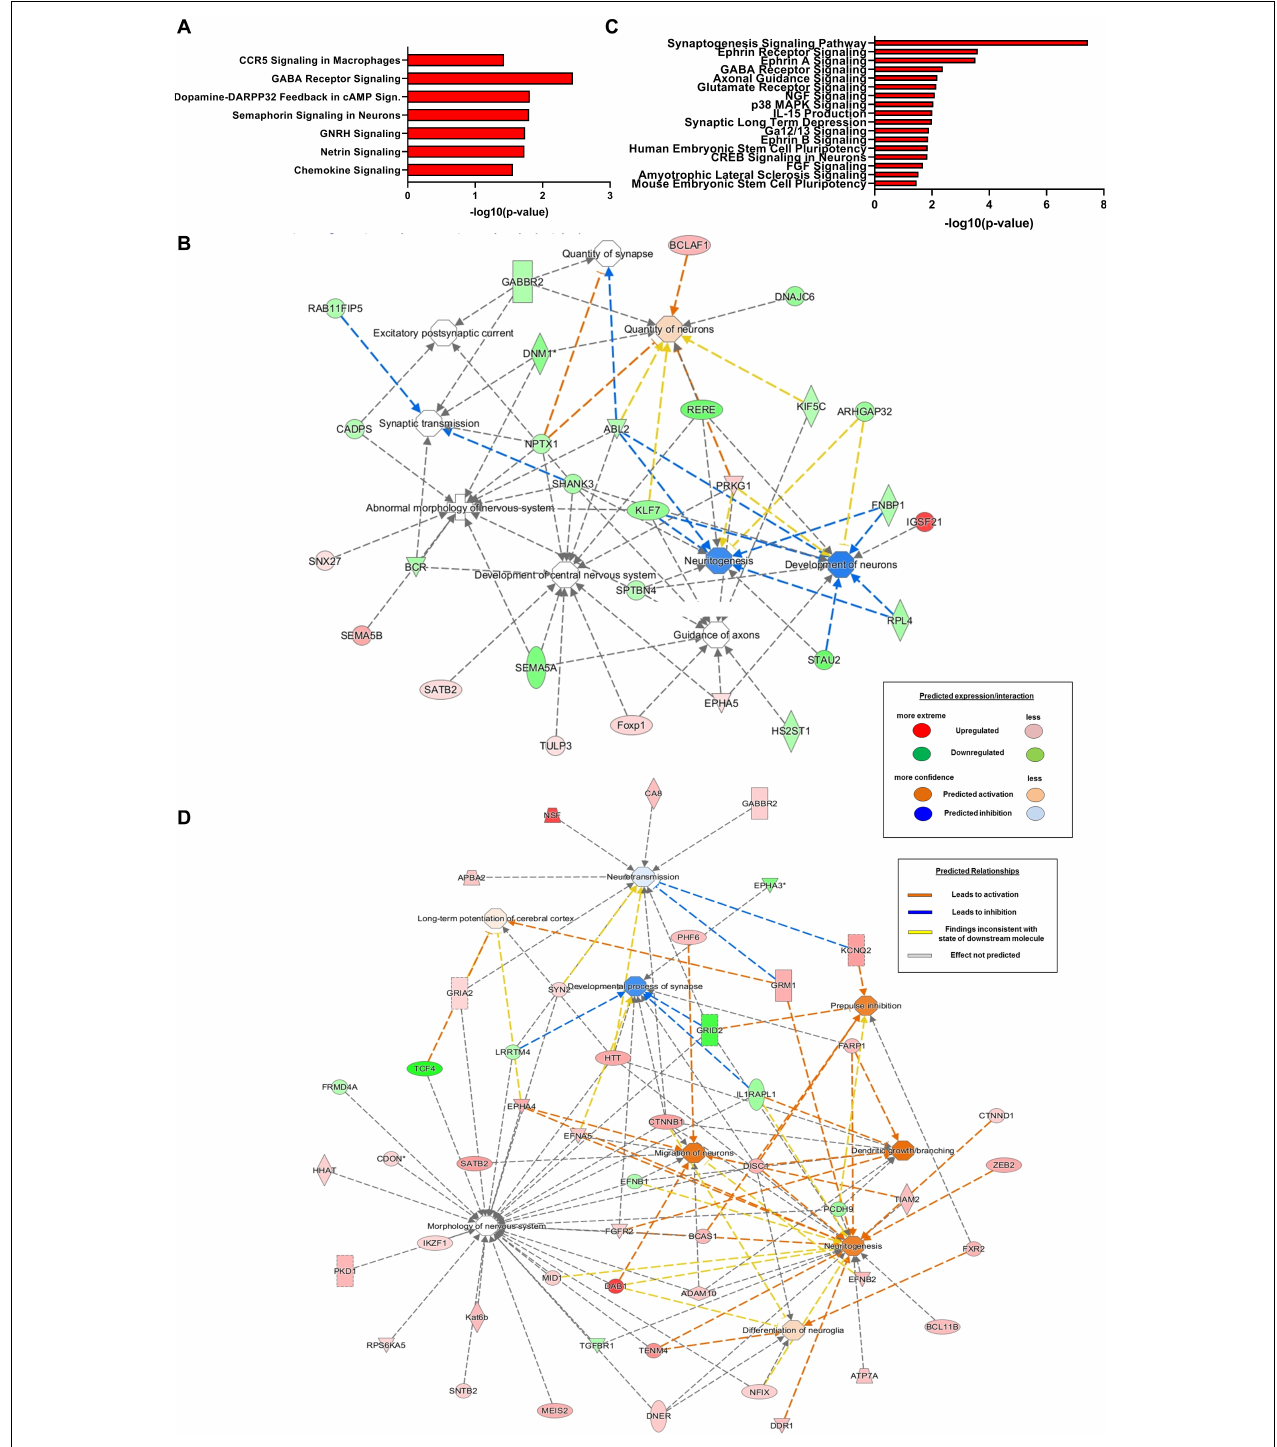
FIGURE 3 | Differentially expressed circRNAs in the prenatal brain following PAE are preferentially generated from genes with relevance to neuronal development and function. (A–D) Molecular network and pathway analysis of host genes of PAE-altered circRNAs in a sex-specific manner (Ingenuity Pathway Analysis). (A,B) Canonical pathways of host genes of differentially expressed circRNAs in female PAE vs. female SAC E18 whole brain ( A ; cutoff lowered to 1.25-fold with p < 0.05) and male PAE vs. male SAC E18 whole brains ( B ; cutoff lowered to 1.25-fold with p < 0.05). (C , D) Molecular networks of host genes of differentially expressed circRNAs in female PAE vs. female SAC E18 whole brain (C) male PAE vs. male SAC E18 whole brains. (D) The same cutoff criteria were used as in (A,B) . A table explaining the depiction of predicted expression, interactions, and relationships between these networks is also displayed.